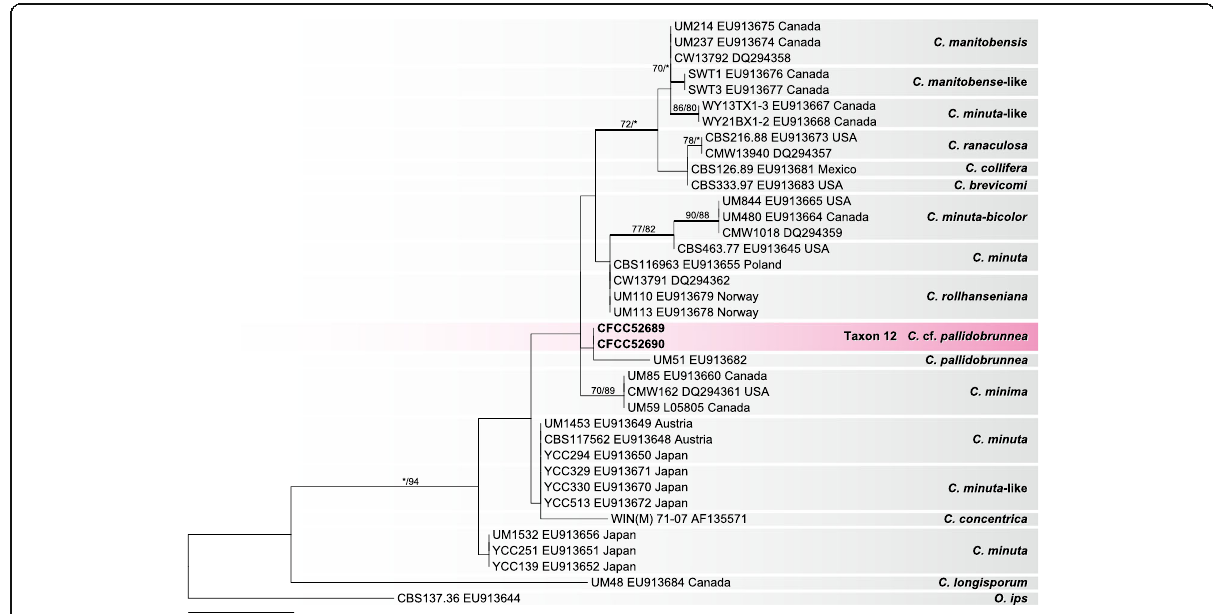
Fig. 11 ML tree of Ceratocystiopsis generated from the LSU sequence data. Sequences generated from this study are printed in bold. Bold branches indicate posterior probability values ≥ 0.9. Bootstrap values of ML/MP ≥ 70% are recorded at the